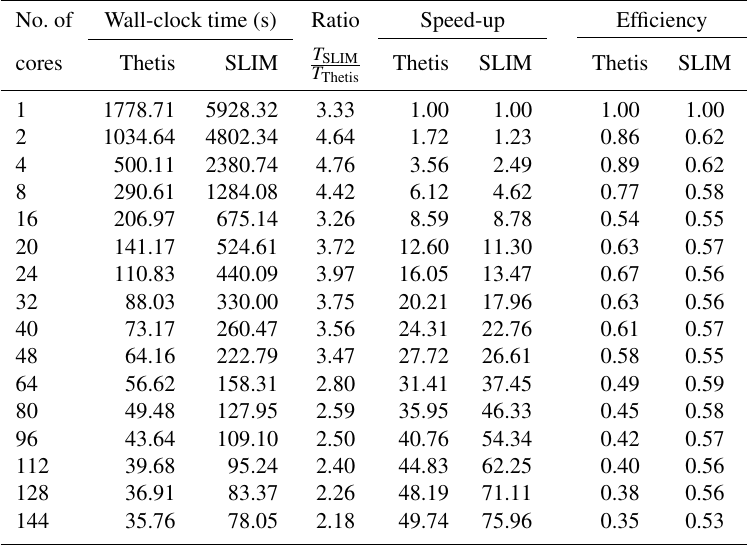
Table B1. CPU time in the baroclinic eddies test case for Thetis and the SLIM 3-D model. Both models ran on identical triangular mesh (4km resolution, 40 vertical levels) using ν 20m 2 s − 1 and a 140s time step. The wall-clock time was recorded over 40 =